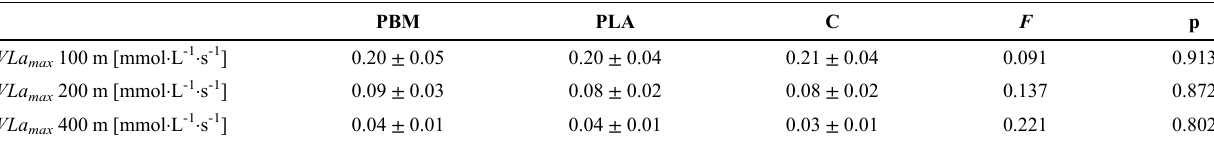
Table 3 - Comparison of maximal lactate production rate accumulation rate for distances of 100-, 200- and 400-m in front crawl swimming in three dif- ferent